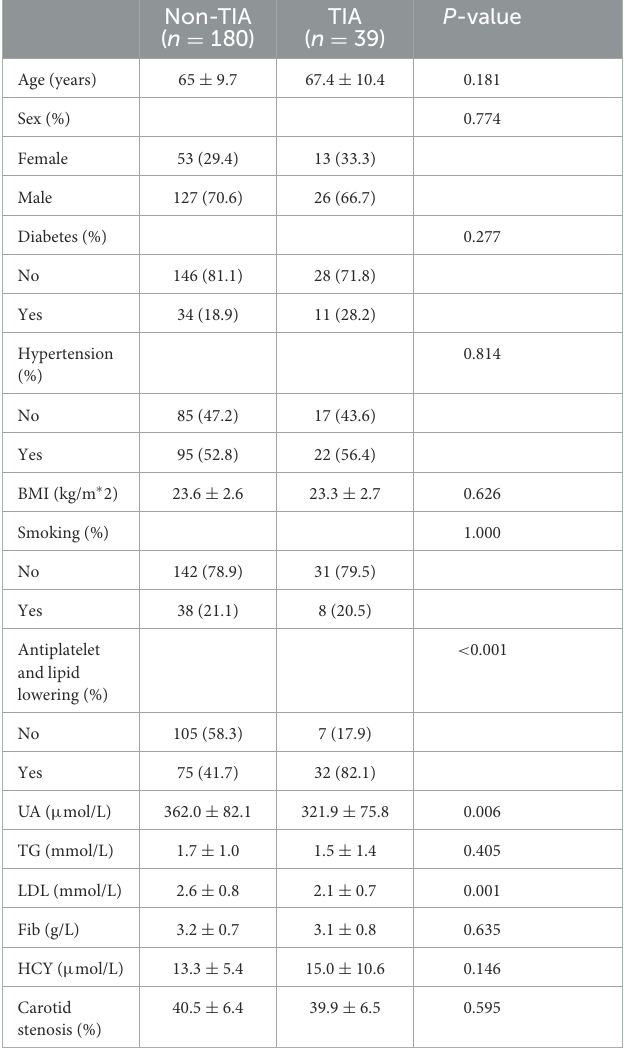
TABLE 1 Stenosis degree and clinical